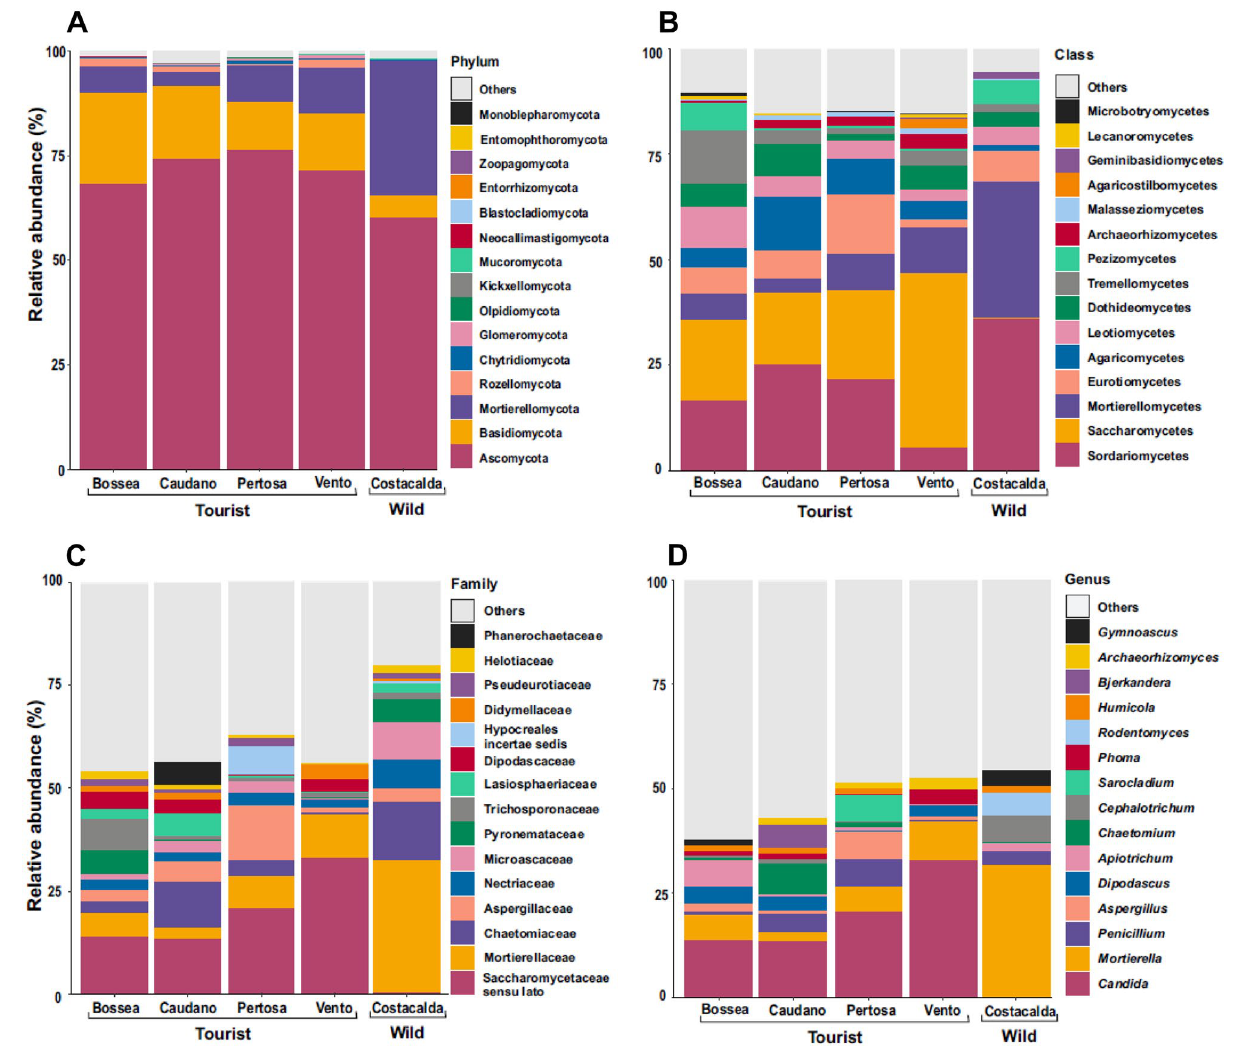
Figure 2. Fungal community composition of 5 examined caves: Bossea, Caudano Pertosa-Auletta, Vento (show-caves) and Costacalda (wild cave). The top 15 most abundant taxa are shown for taxonomic ranks: phylum ( A ), class ( B ), family ( C ) and genus ( D